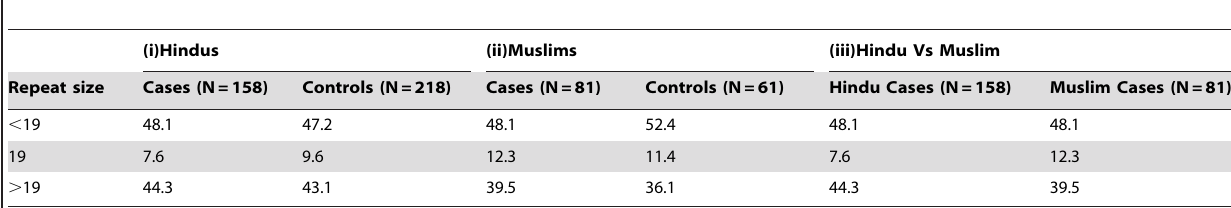
Table 3. Distribution (%) of PCOS cases and controls according to the qualitative categories of CAG repeats in Hindus and Muslims.